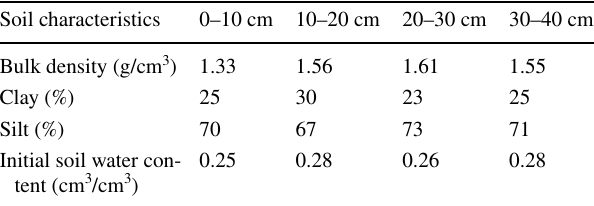
Table 2 Initial soil characteristics of the lime concretion black soil in the Huaibei Plain study area in Anhui Province, China Soil